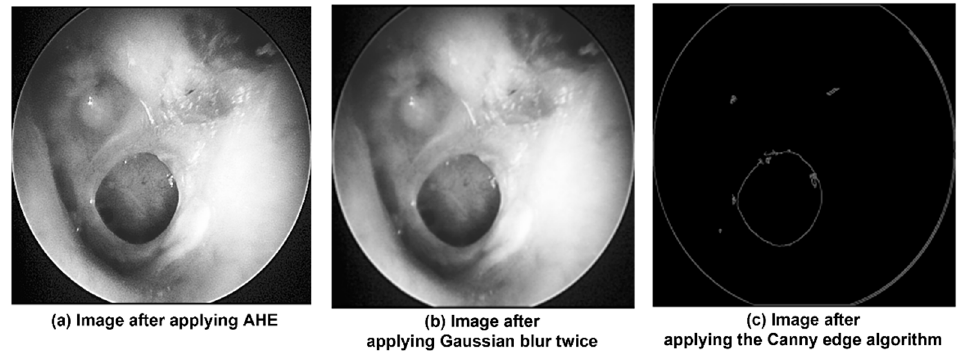
Figure 5. Process of applying Canny edge-detection algorithm.